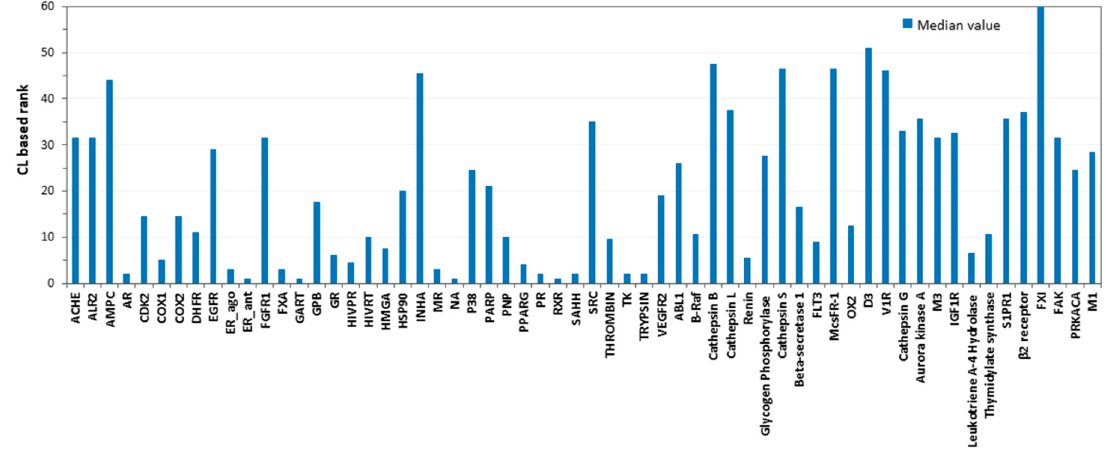
Figure 2. Results of the consensus docking (score) analysis. Blue bars represent the ranking position (based on the consensus level, CL) estimated for the proper target of each ligand, with respect to the others. In this picture, the median values of the target ranking positions obtained for the 10 ligands belonging to the same target were calculated.